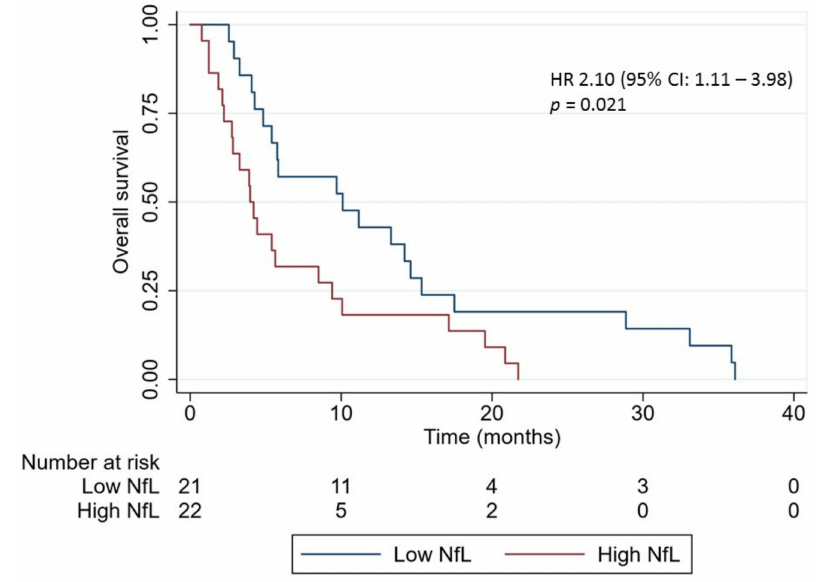
Figure 4. Kaplan–Meier curves for overall survival in lung cancer patients with brain metastasis according to the neurofilament light chain (NfL) level at time of brain metastasis diagnosis ( N = 43). Patients were divided in a low and high NfL level group according to the median NfL level. p -value was calculated by the log-rank test. Abbreviation: NfL: Neurofilament light chain; HR: hazard ratio; CI, confidence